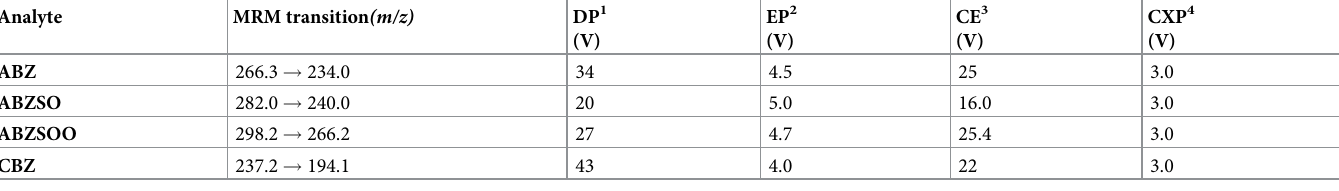
Table 1. Optimized MS/MS parameters for ABZ, ABZSO, ABZSOO and CBZ.